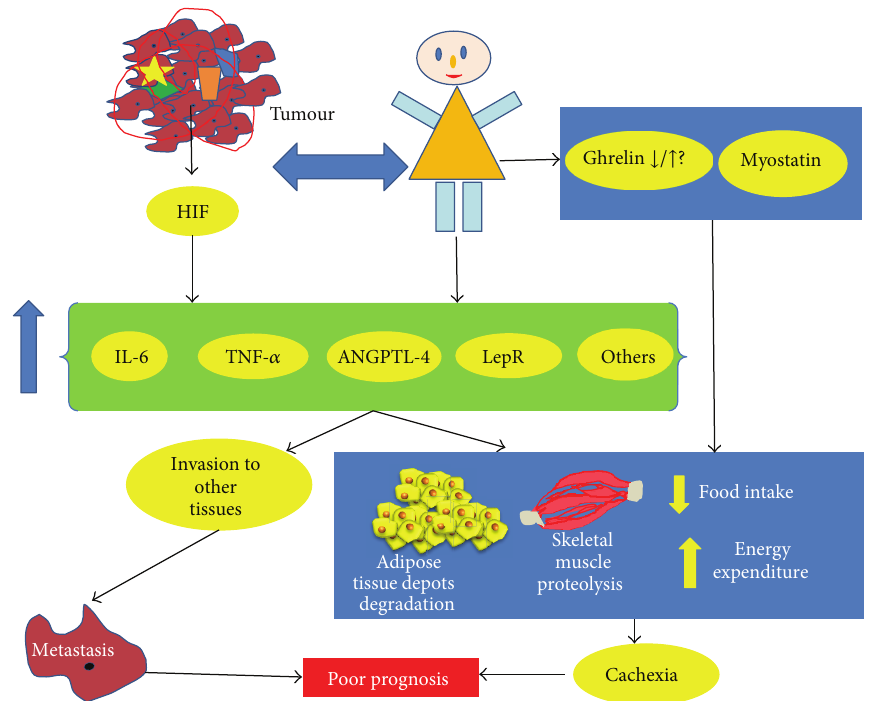
Figure 2: Schematic illustration of the cross talk between micro- and macroenvironment in the tumour-bearing patient. The importance of hypoxia and proinflammatory factors for tumour metastasis and cancer